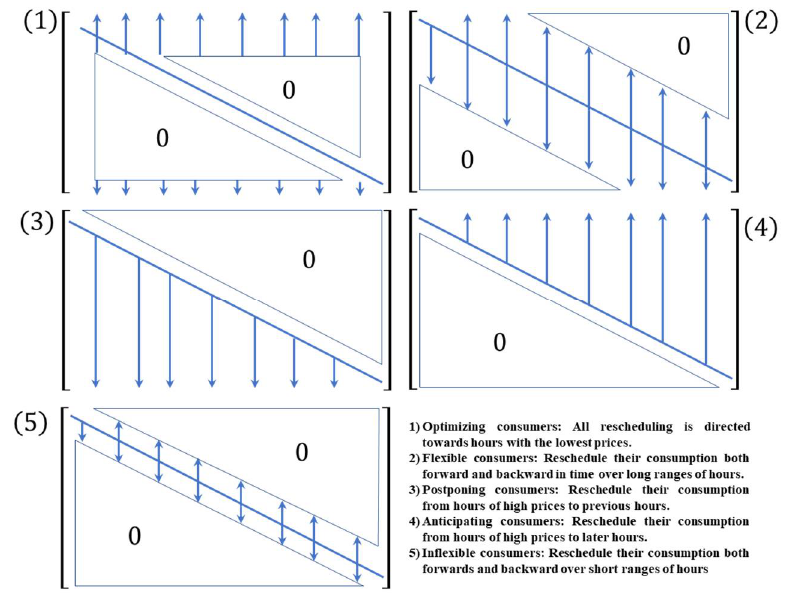
Figure 6. Different consumer rescheduling behaviors in DR markets.